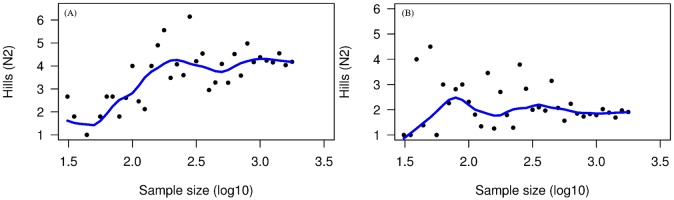
Random sampling of the first and second halves (15 min segments) of the test set.Hill’s N2 Diversity index is plotted against the log10-transformed number of frames sampled. Only one of 10 trials is shown for each half-transect. The blue line is the LOWESS (locally weighted) regression line. Diversity leveled out at sample sizes around 102.5 (316 frames) in (A), and at about 102.6 (398 frames) in (B).